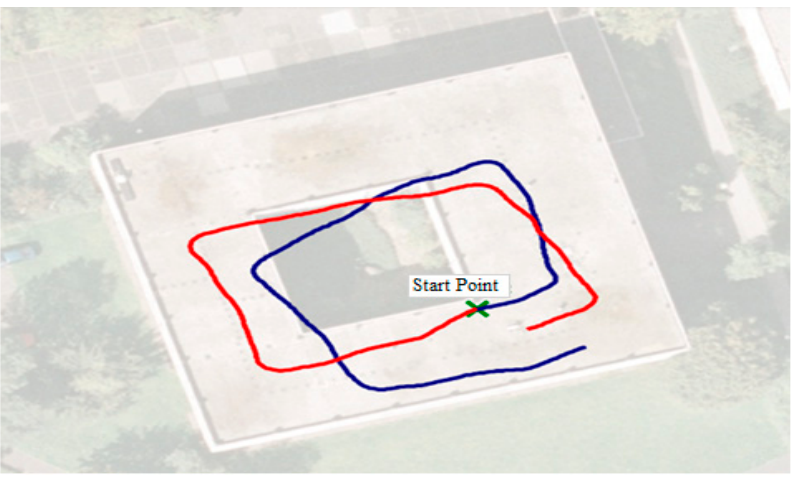
Figure 12. Self-estimates of robot position. Blue track was travelled counter-clockwise and red track was travelled clockwise.